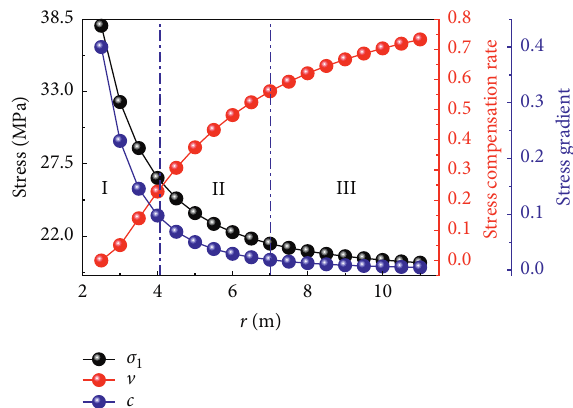
Figure 9: Distribution of stress gradient and stress compensation rate.